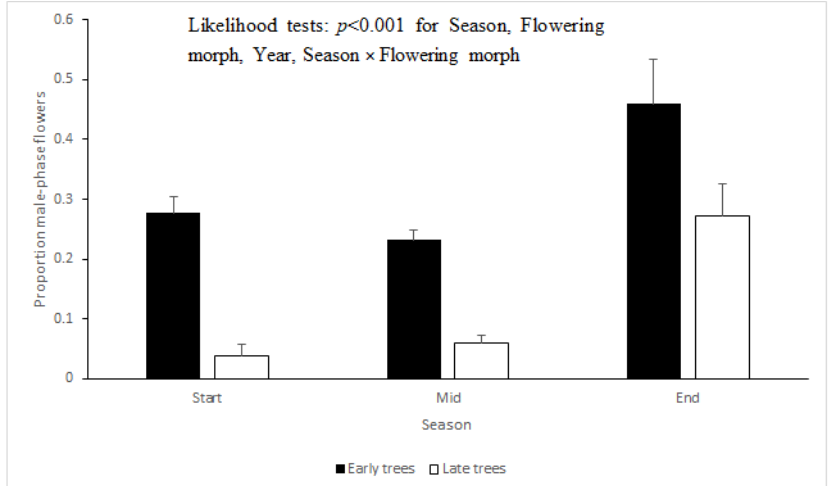
Figure 1. Mean per-tree proportions of male-phase flowers, in the ‘Early’ and ‘Late’ flowering morphs along the flowering season. Error bars are 1 SE. All trees were sampled between 08:30–10:30 h.